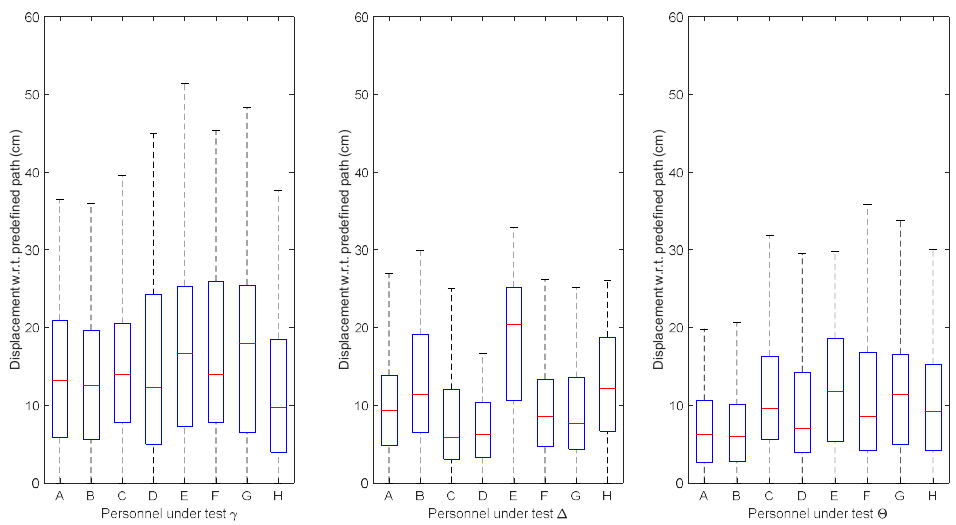
Figure 14. Displacement to predefined path in field tests.